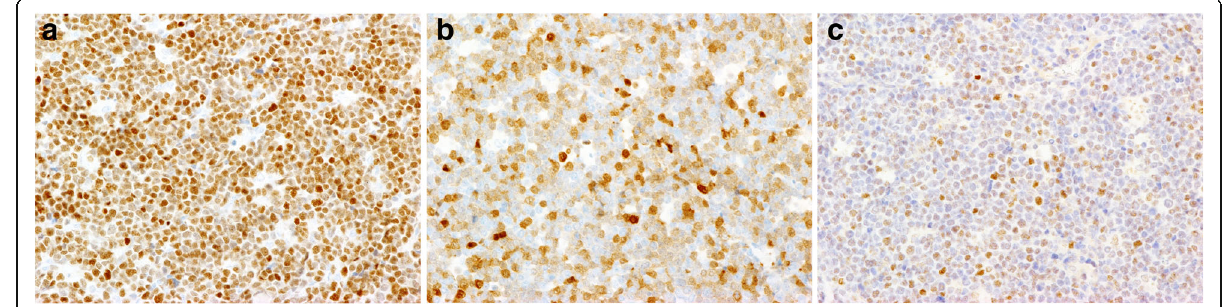
Fig. 2 Immunohistochemical staining of thyroid Burkitt ’ s lymphoma: The nuclei are positive for MUM-1 ( a ) and p16 ( b ), and focally positive for MDM2 ( c ) (×